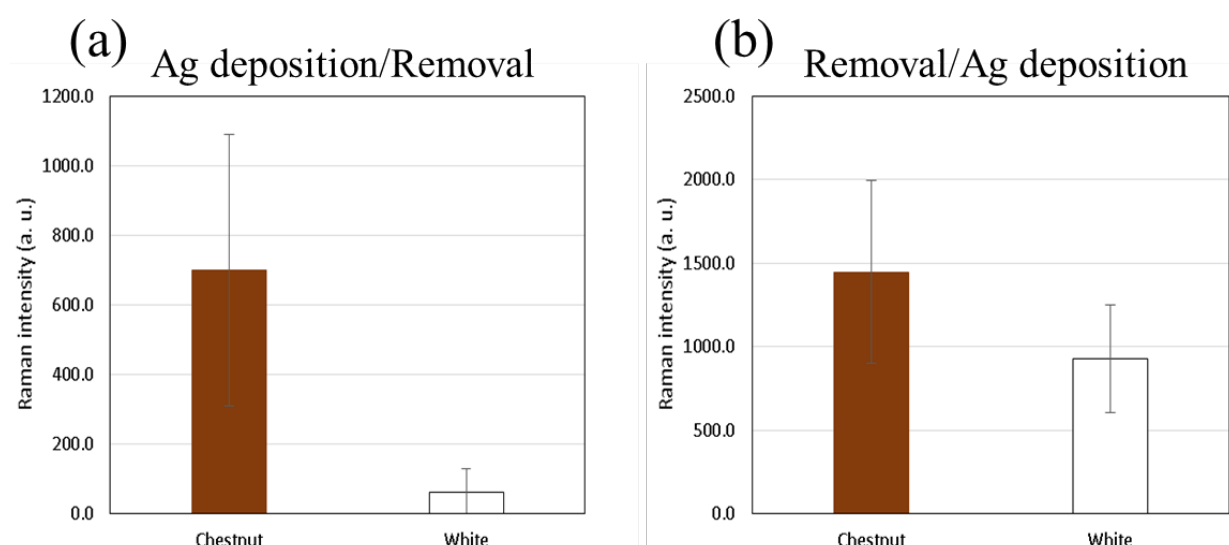
Figure A8. A bar graph summarizing 774 cm − 1 band intensities for chestnut and white scales of S. charonda , with silver evaporated ( a ) before and ( b ) after removal.